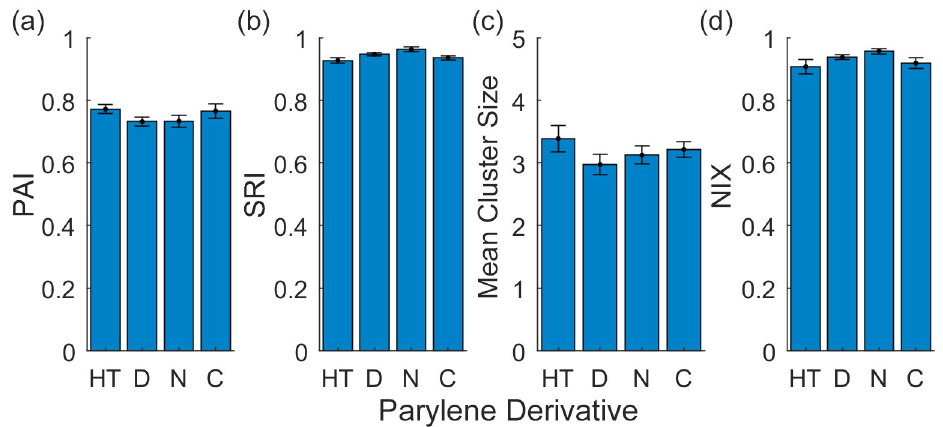
Fig 6. Quantification of astrocyte patterning on parylene-HT, parylene-D, parylene-N and parylene-C substrates. (a) PAI, (b) SRI, (c) Mean Cluster Size, and (d) the NIX. https://doi.org/10.1371/journal.pone.0218850.g006 Table 2 quantify the quality of patterning terms of cell adhesion (PAI), patterning fidelity